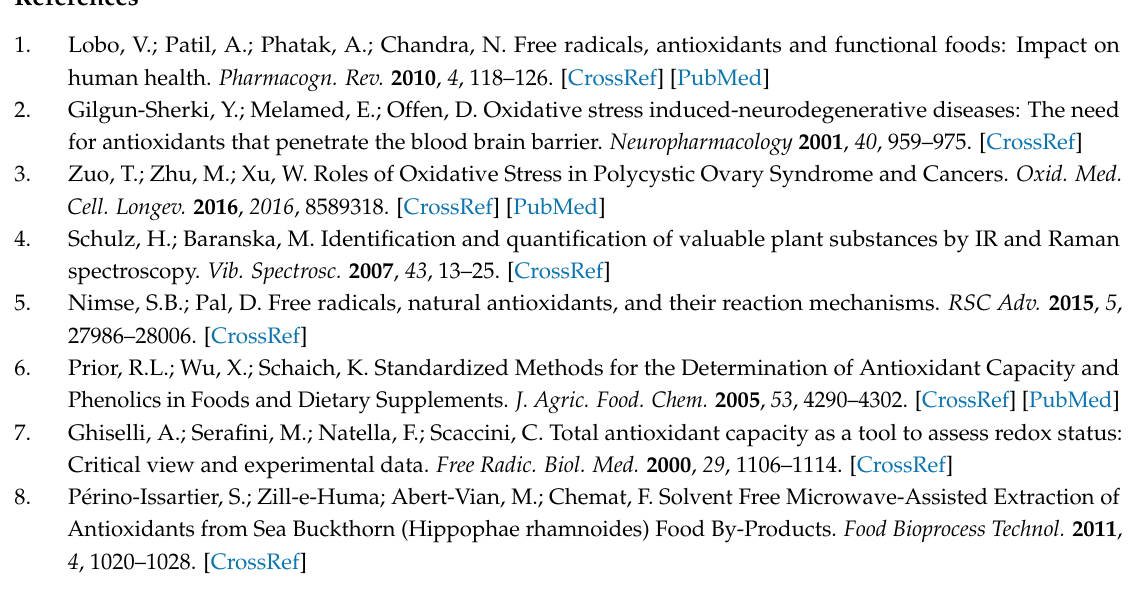
Figure S1: CV in 0.1 M NaPB, pH 7.0, in the presence of 6 mM H 2 O 2 addition, v = 50 mV s − 1 for bare SPE (C) and nanoparticle modified SPE with AuNP, CNT and G.; Table S1: Capacitance values calculated for all sensor types from the CVs in Figure S1; Figure S2: Calibration plots recorded at 0.55 V vs. Ag/AgCl in 0.1 M NaPB with an E for different dilutions, pH = 7.0., Table S2: Performance parameters for the three different E:buffer dilutions in Figure S2, Figure S3: Calibration plot of CL signal (I0/I) as a function of Trolox concentrations. Author Contributions: M.F. and M.D. conceived and designed the experiments; A.¸S. performed the electrochemistry measurements, C.V.P. performed the chemiluminescence measurements, and M.D. performed the